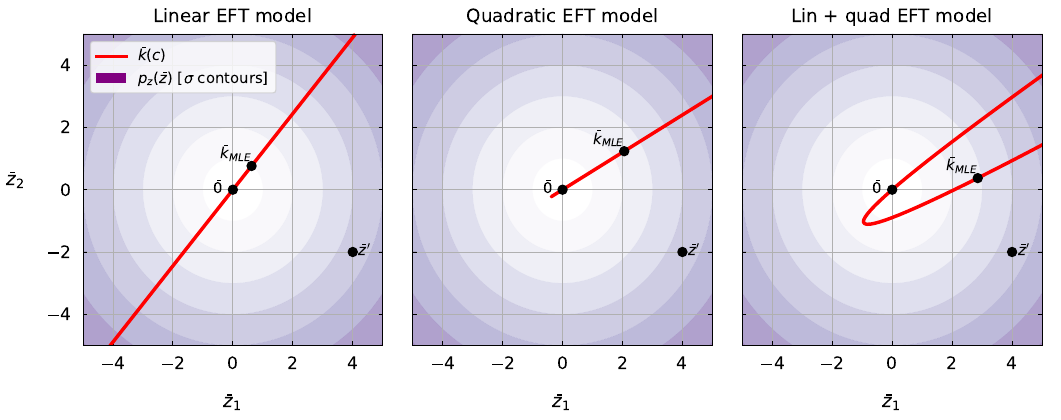
Figure 19: Visualisation of the points of interest for a candidate observation ¯ z ′ .